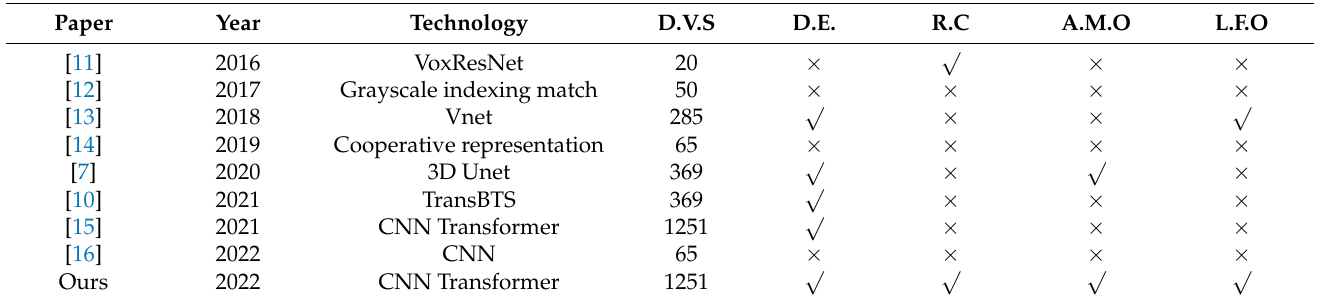
Table 1. Review of the techniques and databases used for the brain tumor image segmentation from 2016 to